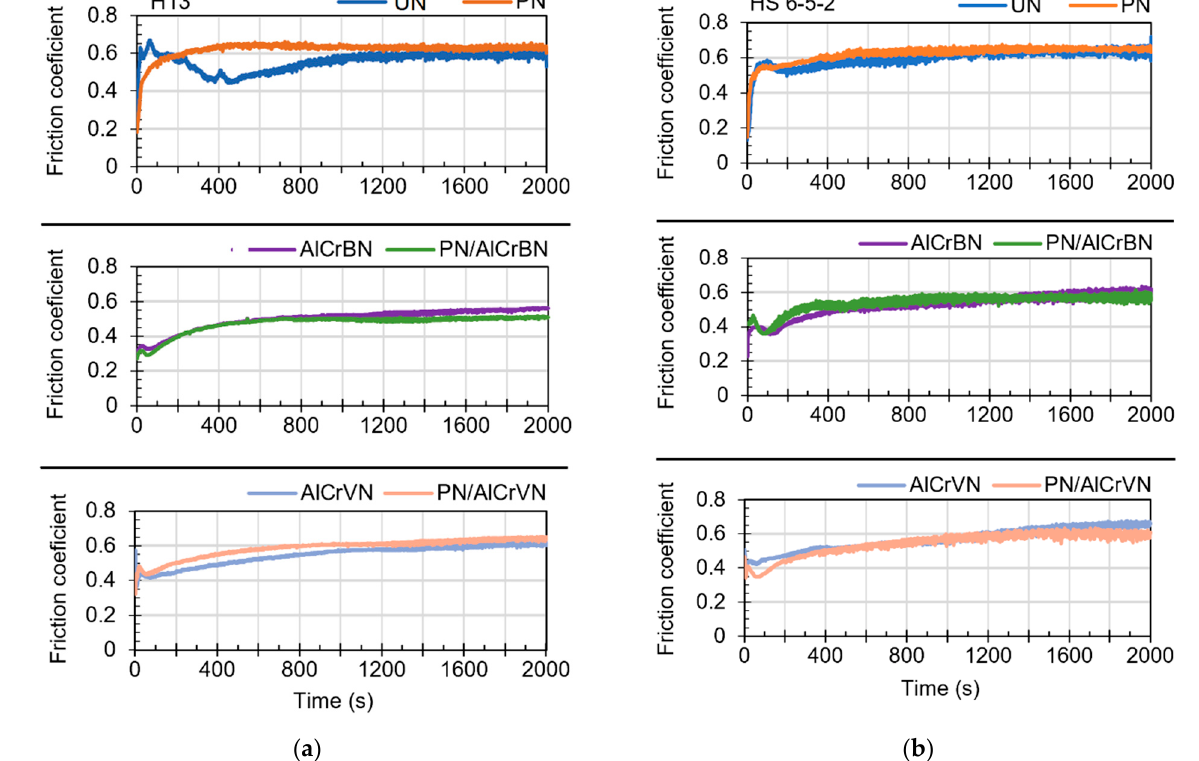
Figure 12. Relationship between the test time and friction coefficients of the tested materials ( a ) Steel H13; ( b ) Steel HS6-5-2.